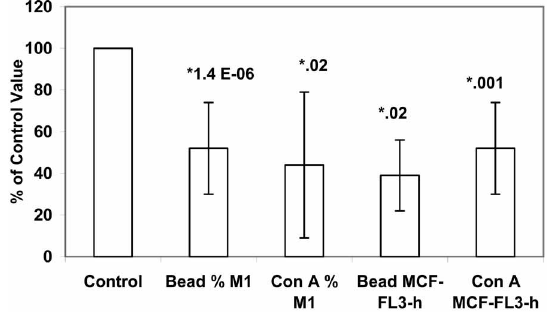
Figure 6. Extraction of cell surface proteins reduces yeast hydrophobicity. Cellular surface proteins were stripped from 12 strains of yeast by treating them with 2ME-SDS-EDTA (see Methods). Both bead-binding parameters were decreased by the stripping procedure, as was binding of fluoresceinated concana- valin